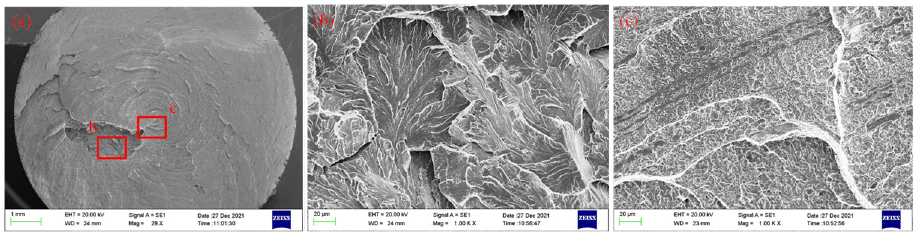
Figure 11. SEM fractography of a tensile specimen (G3): ( a ) overall morphology, ( b ) fracture initiation zone, ( c ) fracture propagation zone, ( b , c ) are the high magnification of ( b , c ) in ( a ).